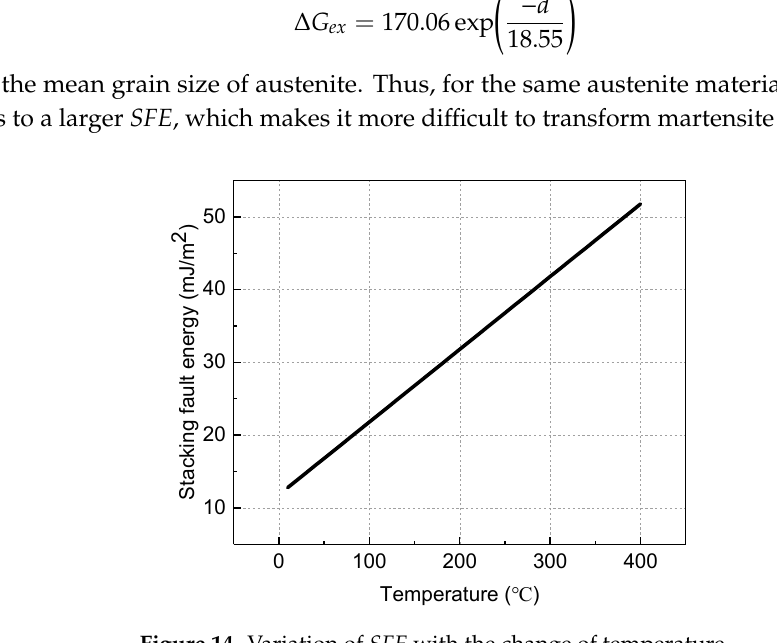
Figure 14. Variation of SFE with the change of temperature.